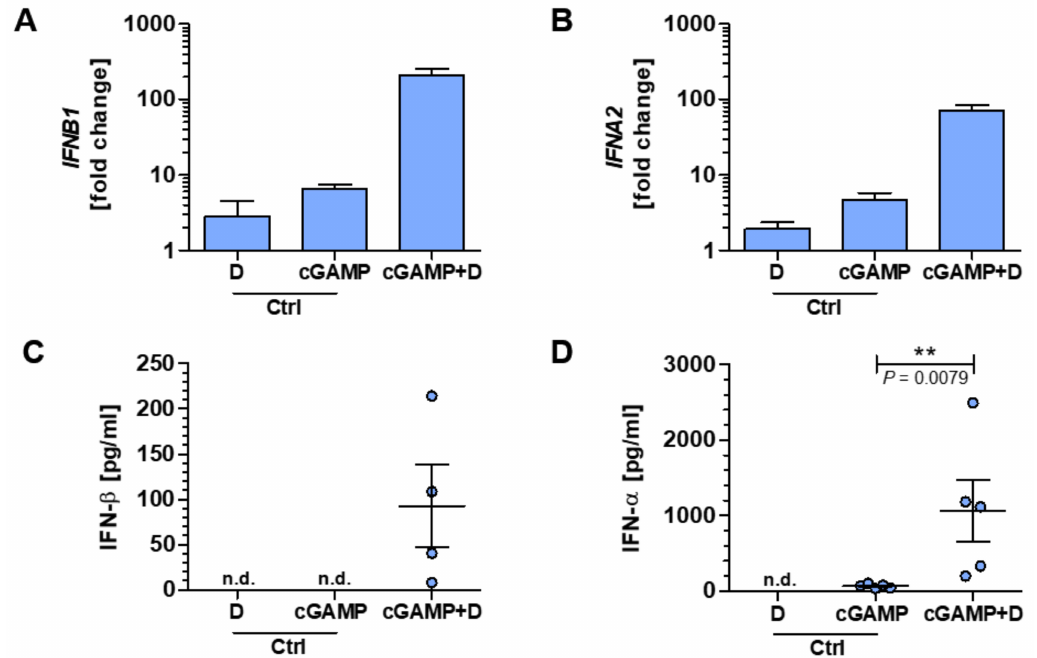
Figure 3. Specific cyclic dinucleotide (CDN) stimulation of PBMC leads to interferon (IFN) type I response. ( A – D ) PBMC were stimulated with the CDN 2 (cid:48) 3 (cid:48) -cGAMP co-delivered with digitonin (here defined as cGAMP + D group) or solely with one of the two and afterward analyzed for their IFN type I responses. Gene expression analysis of IFNB1 ( A ) and IFNA2 ( B ) are shown as fold change relative to an untreated control after 4 h of stimulation. After 24 h of stimulation, the protein concentrations of IFN- β ( C ) or IFN- α ( D ) were determined. Some protein concentrations were under the detection threshold and are indicated as not detectable (n.d.). Of note, in ( C ), one sample was also below the detection threshold within the cGAMP + D group. Each data point represents an individual HD. Data were compiled from five independent experiments. Data in ( D ) were analyzed by Mann-Whitney U -test, and the level of significance was labeled as ** p < 0.01. Abbreviations: 2 (cid:48) 3 (cid:48) - cyclic guanosine monophosphate–adenosine monophosphate (2 (cid:48) 3 (cid:48) -cGAMP), control (Ctrl) .